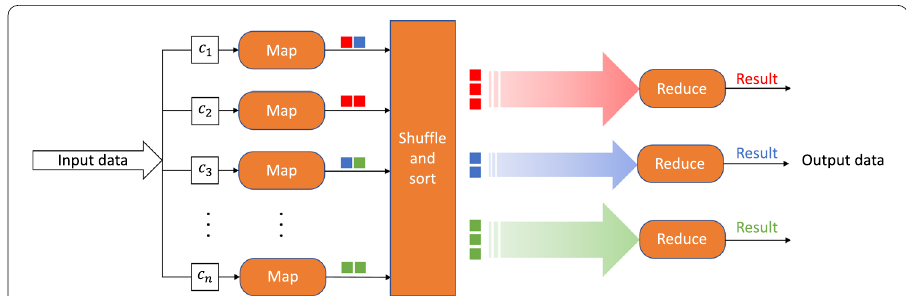
Fig. 1 MapReduce data partitioning and processing on horizontally scaled